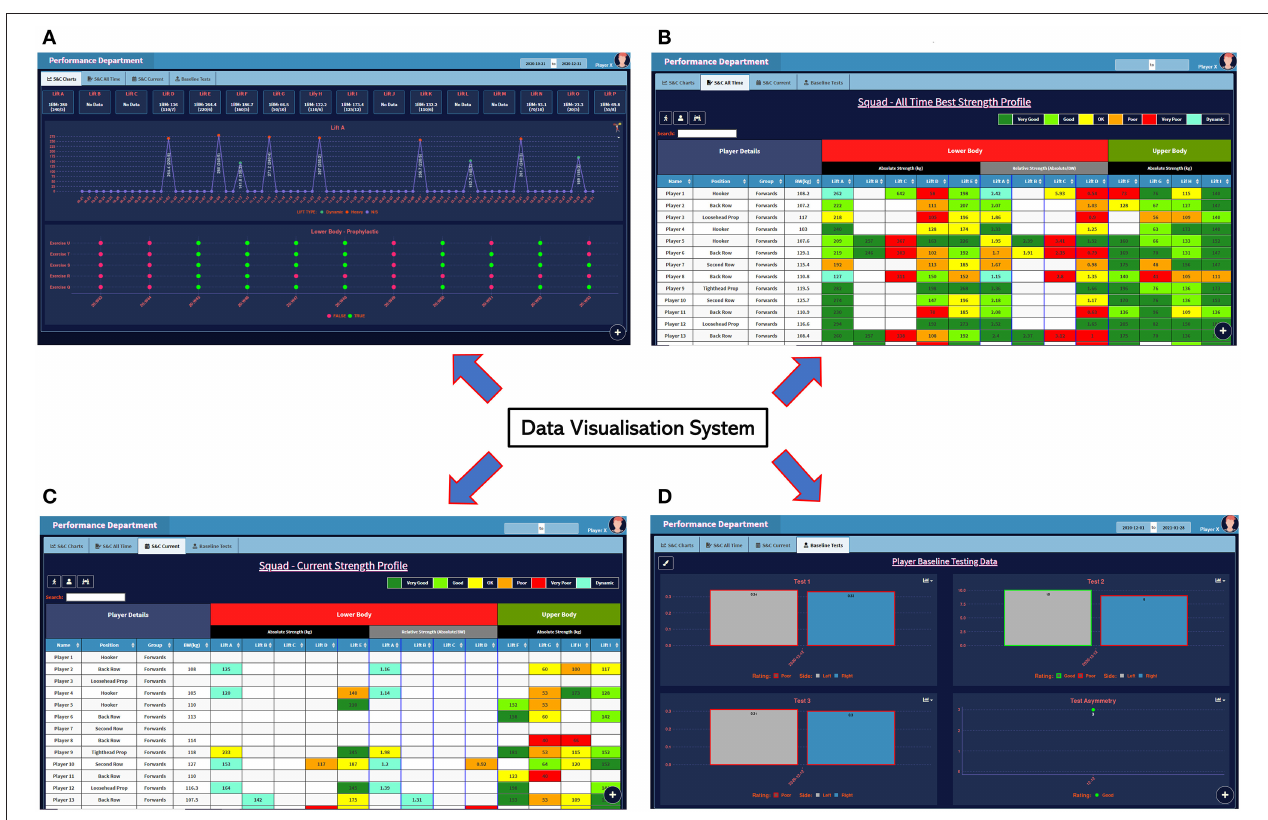
FIGURE 8 | Strength and conditioning data visualization system (interface) MVP (A) S&C Charts (B) S&C All Time (C) S&C Current (D) Baseline